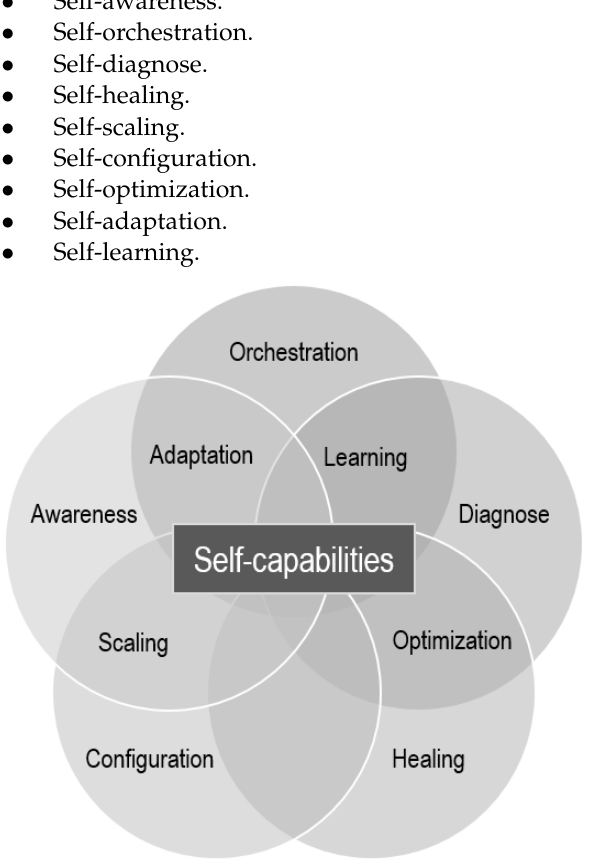
Figure 5. Classification of the self-capabilities defined for this article.